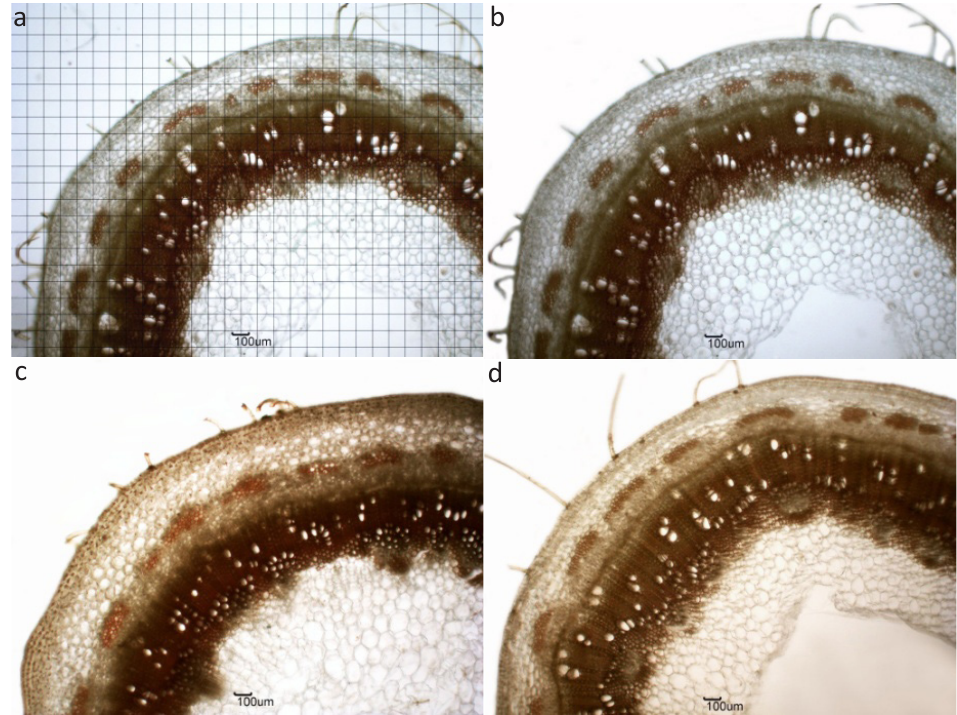
Fig. 4. Cross-sections of L. albus middle stem segments: (a) Cross-section of L. albus stem with superimposed point grid test system consisting of 588 test points; (b) L. albus grown as sole stand; L. albus intercropped with (c) V. sativa and (d) V. narbonensis